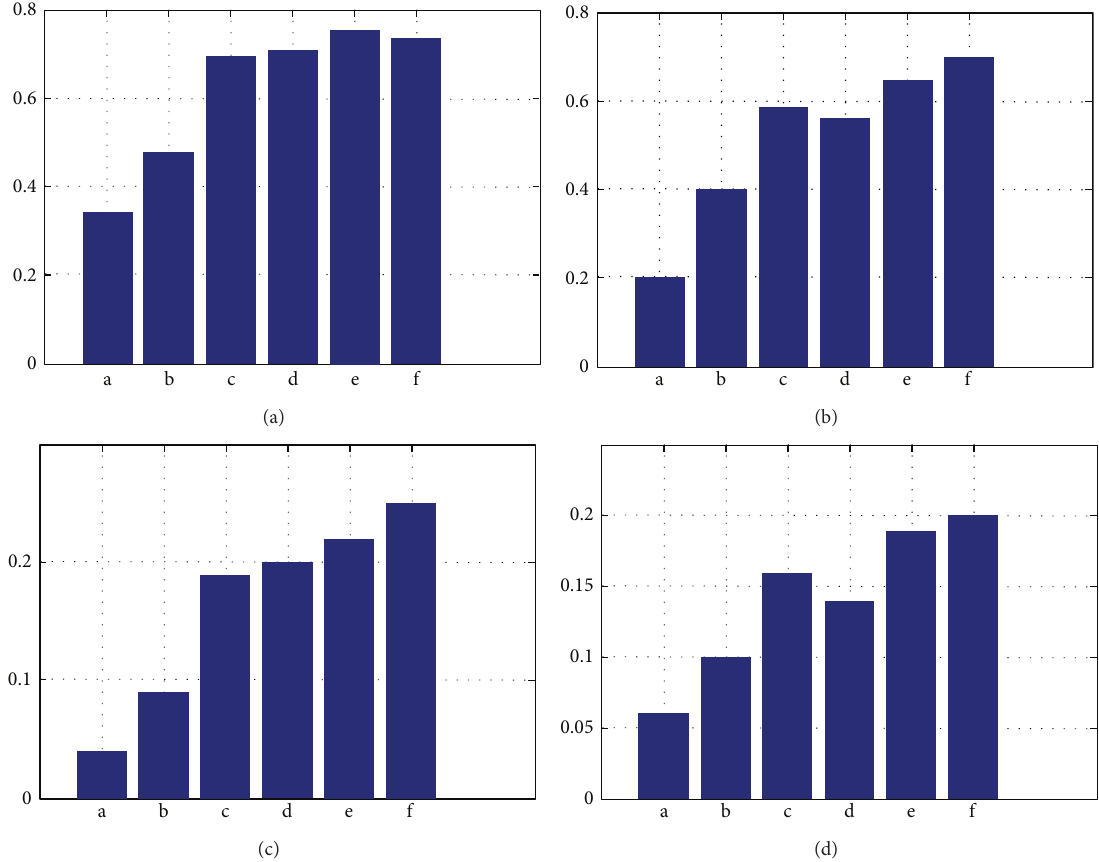
Figure 9: The comparison histogram of experiments ((a) the average recall of 49 labels, (b) the average precision of 49 labels, (c) the average recall of 260 labels, and (d) the average precision of 260 labels, where, a.TM b.CMRM c.CRM d.PLSA-WORDS e.PLSA-FUSION f.OURS).